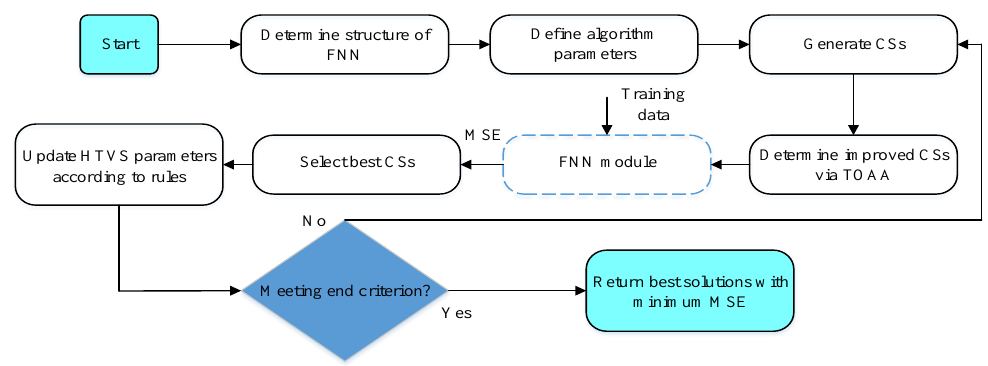
Figure 3. Flowchart of the FNNHTVS